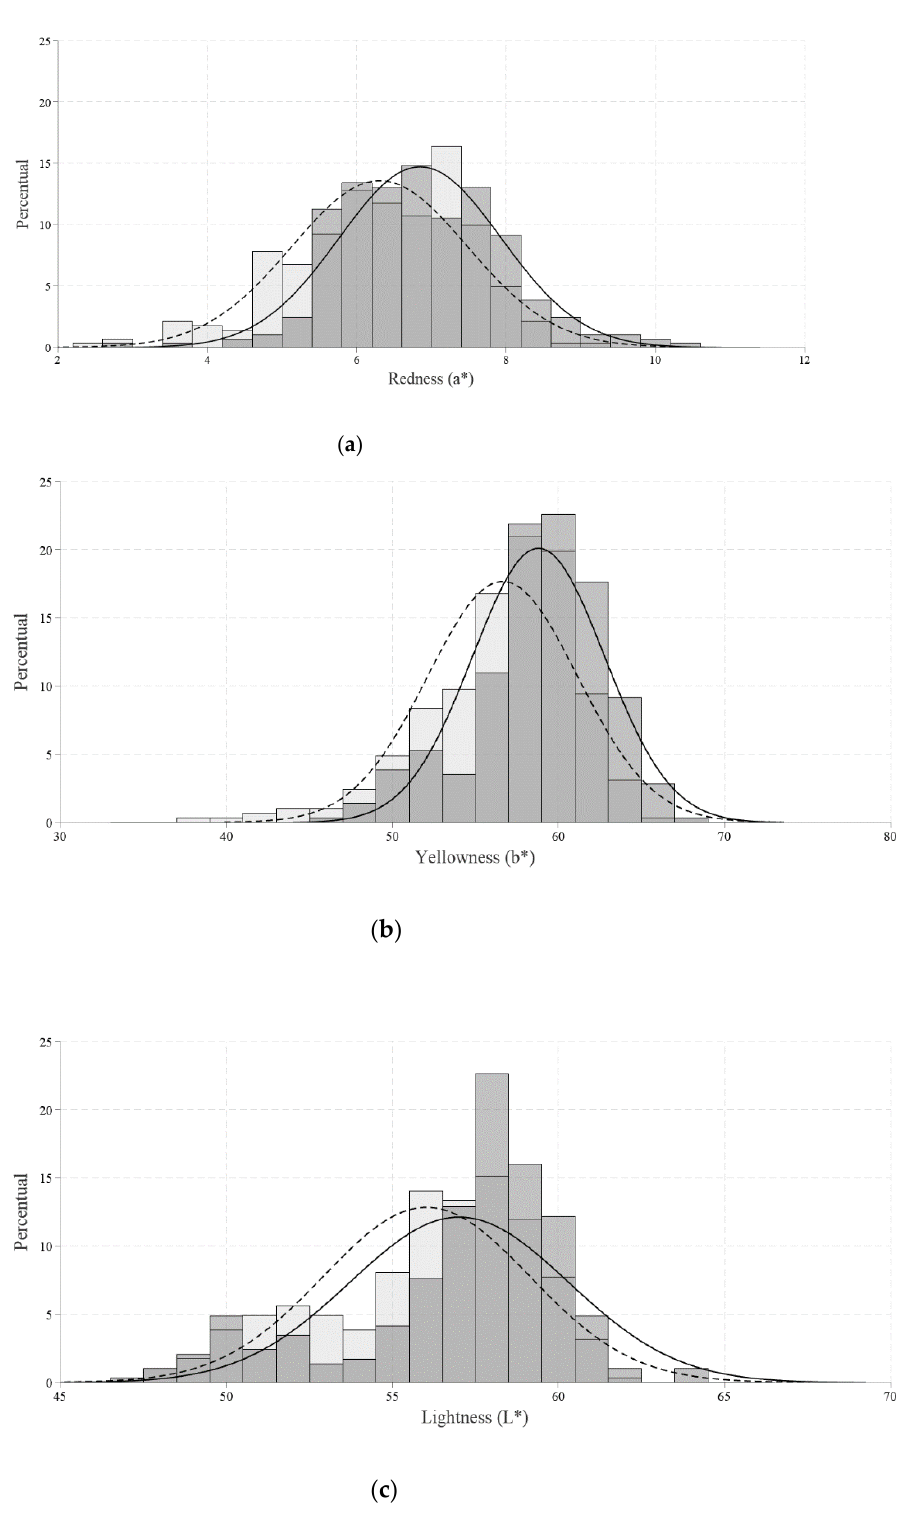
Figure 1. Yolk redness (a*) ( a ), yellowness (*L) ( b ), and lightness (L* color) ( c ) of eggs from laying hens fed β -mannanase (dark gray bars) or control treatment (light gray bars).